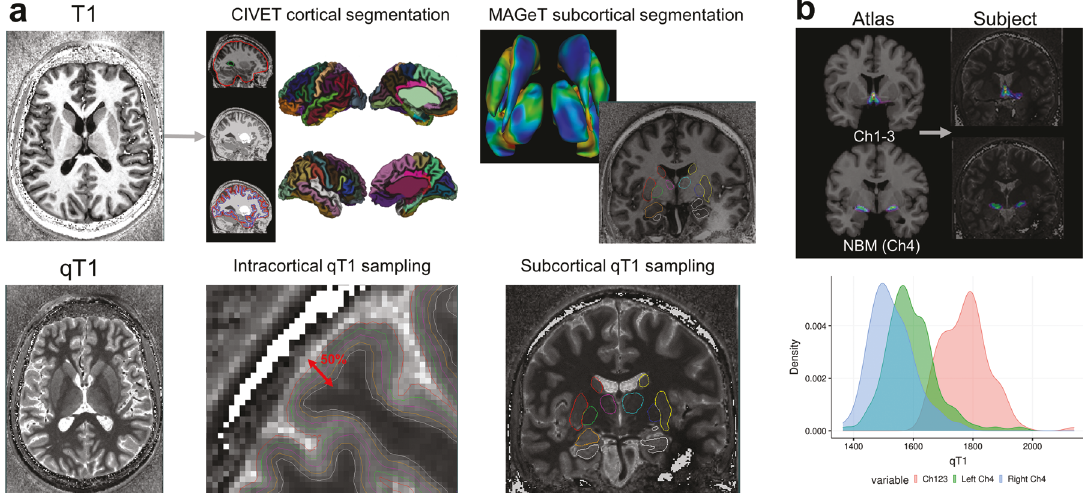
Fig. 2 Image preprocessing of cortical, subcortical, and basal forebrain structures. a qT1 and T1-weighted MRI data at 7T were acquired using the MP2RAGE sequence. The CIVET pipeline (version 2.1.0) was used to delineate the cortical surfaces and sampling at multiple depths, and we sample qT1 measures at 50% depth from the pial to white matter surface. Subcortical qT1 sampling along MAGeT Brain-generated structures (hippocampus, amygdala, striatum, thalamus, globus pallidum). b Mapping probabilistic atlas based on cytoarchitectonic data of the basal forebrain structures onto individual subjects through non-linear registration. Histogram shows group distribution of qT1 values for the three structures — Ch1-3, left and right Ch4